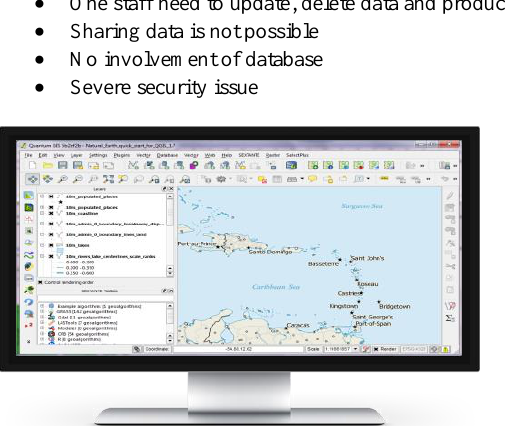
Figure 10: Illustration of a stand-alone system